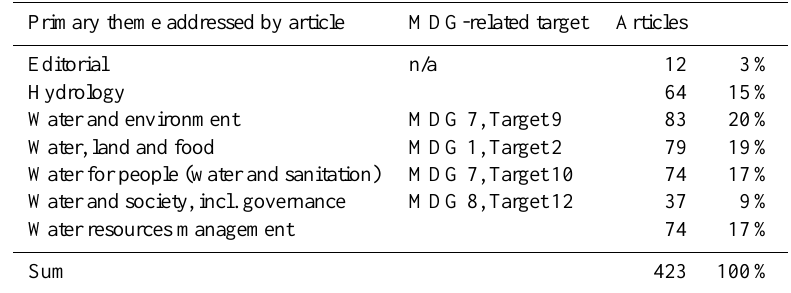
Table 4. Articles that address selected targets of the MDGs, and published in the WaterNet/WARFSA Special issues of Physics and Chemistry of the Earth,